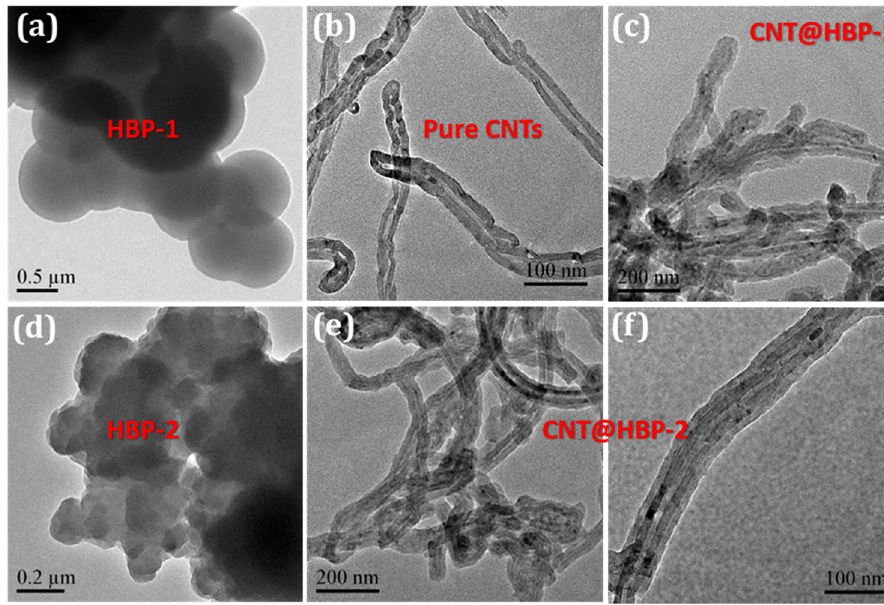
Figure 3: Typical TEM images of ( a ) HBP - 1, ( b ) CNTs, ( c ) CNT@HBP - 1, ( d ) HBP - 2, and ( e and f ) CNT@HBP -